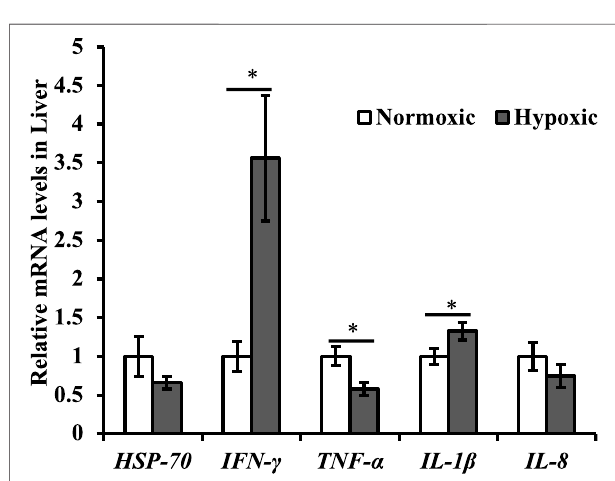
FIGURE 3 | Effect of acute hypoxic stress on the expression of the antioxidant-related genes in the liver of triploid rainbow trout ( n = 6; Nrf2, nuclear factor erythroid 2 related factor 2; SOD, superoxide dismutase; CAT, catalase; GPx, glutathione peroxidase). Asterisks indicate signi fi cant differences ( t -test; * p < 0.05; ** p < 0.01).